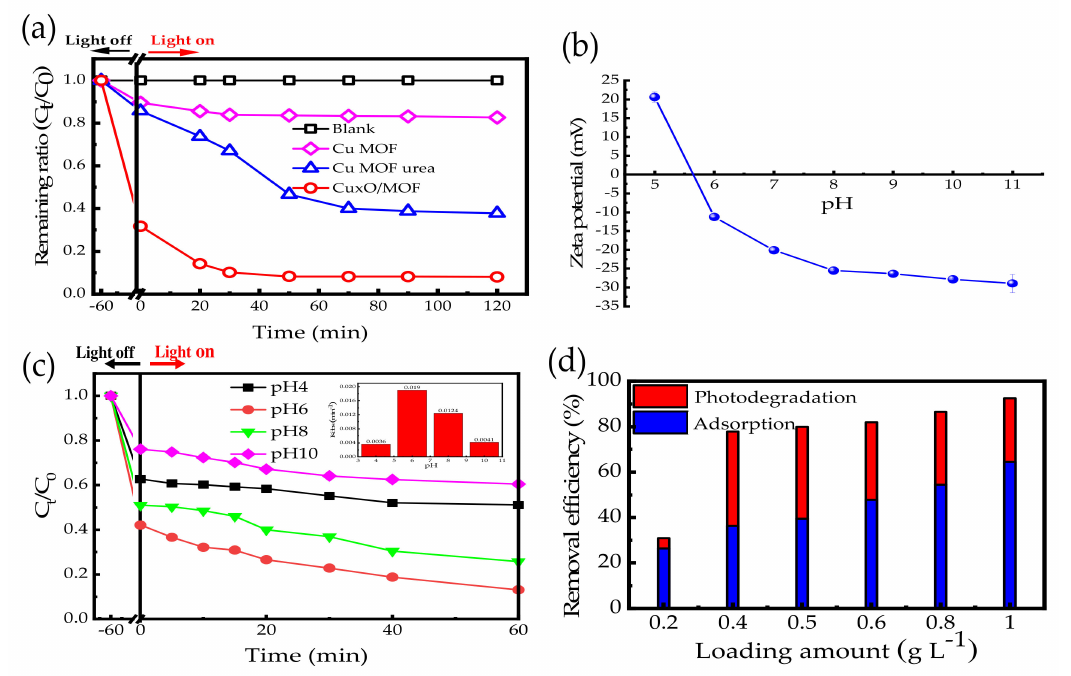
Figure 4. Photodegradation of 10 mg L − 1 CIP over ( a ) 1.0 g L − 1 of the MOF-based photocatalysts, and ( b ) zeta potential of Cu x O/MOF, ( c ) photodegradation efficiency of CIP by Cu x O/MOF as a function of the pH, ranging from 4 to 10, and ( d ) different loading amounts of Cu x O/MOF, ranging from 0.2 to 1.0 g L − 1